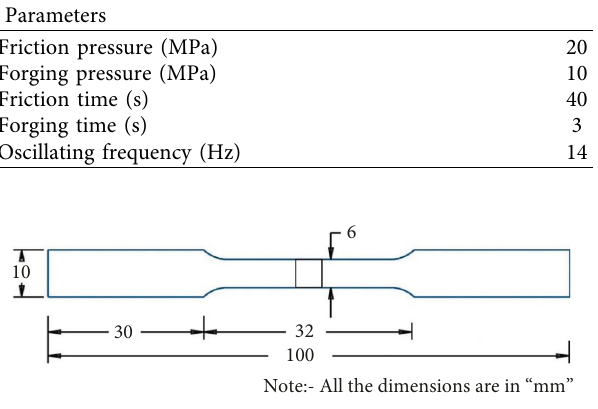
Figure 5: Dimensions of the tensile test specimen.